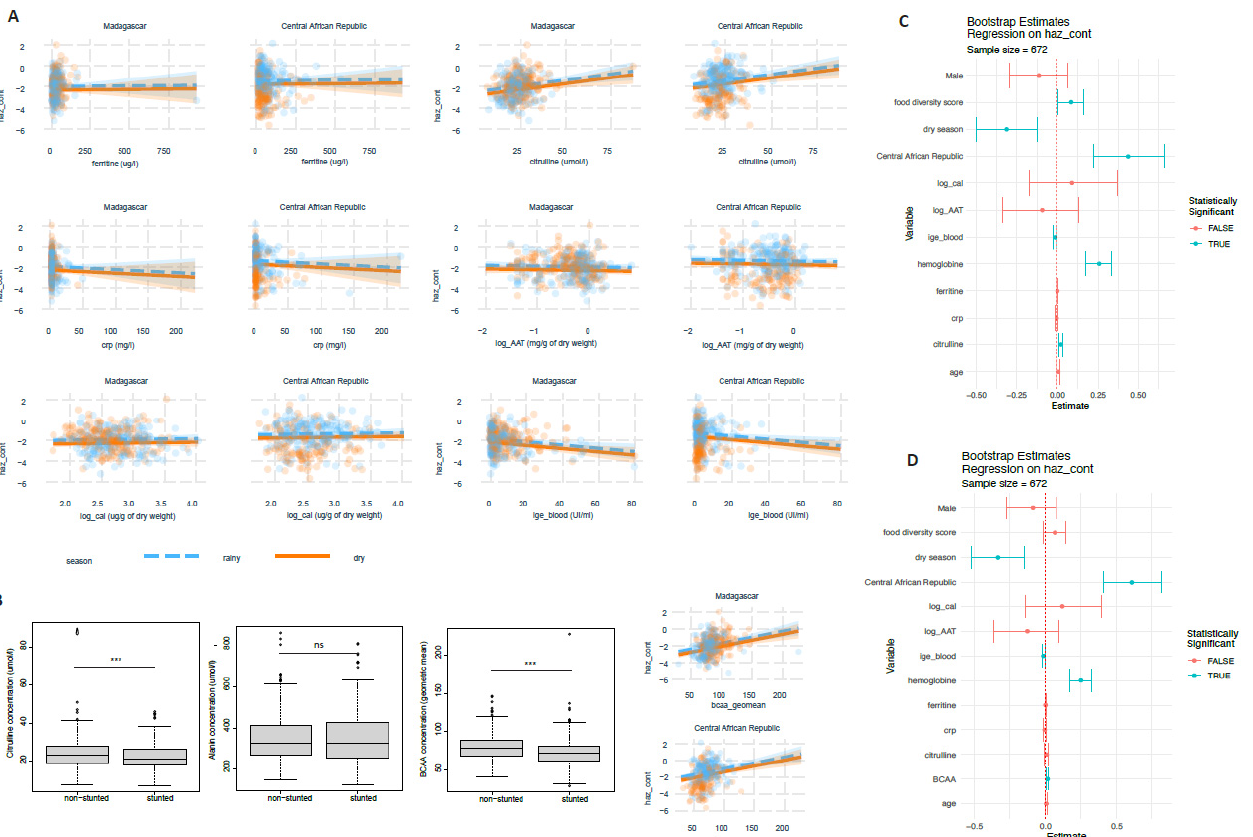
Figure 4. Putative biomarkers and their association with growth delay: ( A ) association of different biomarkers with height-for-age z-score; ( B ) blood amino acid levels as a function of stunting status; ( C ) regression results of the main biomarkers and potential confounders and stunting; ( D ) regression results of the main biomarkers and potential confounders including branched-chain amino acids (BCAA) and stunting. Significant associations ( p < 0.05) are indicated in blue. Correlations are based on non-parametric Spearman correlation; ***: p < 0.01, ns: p > 0.05.